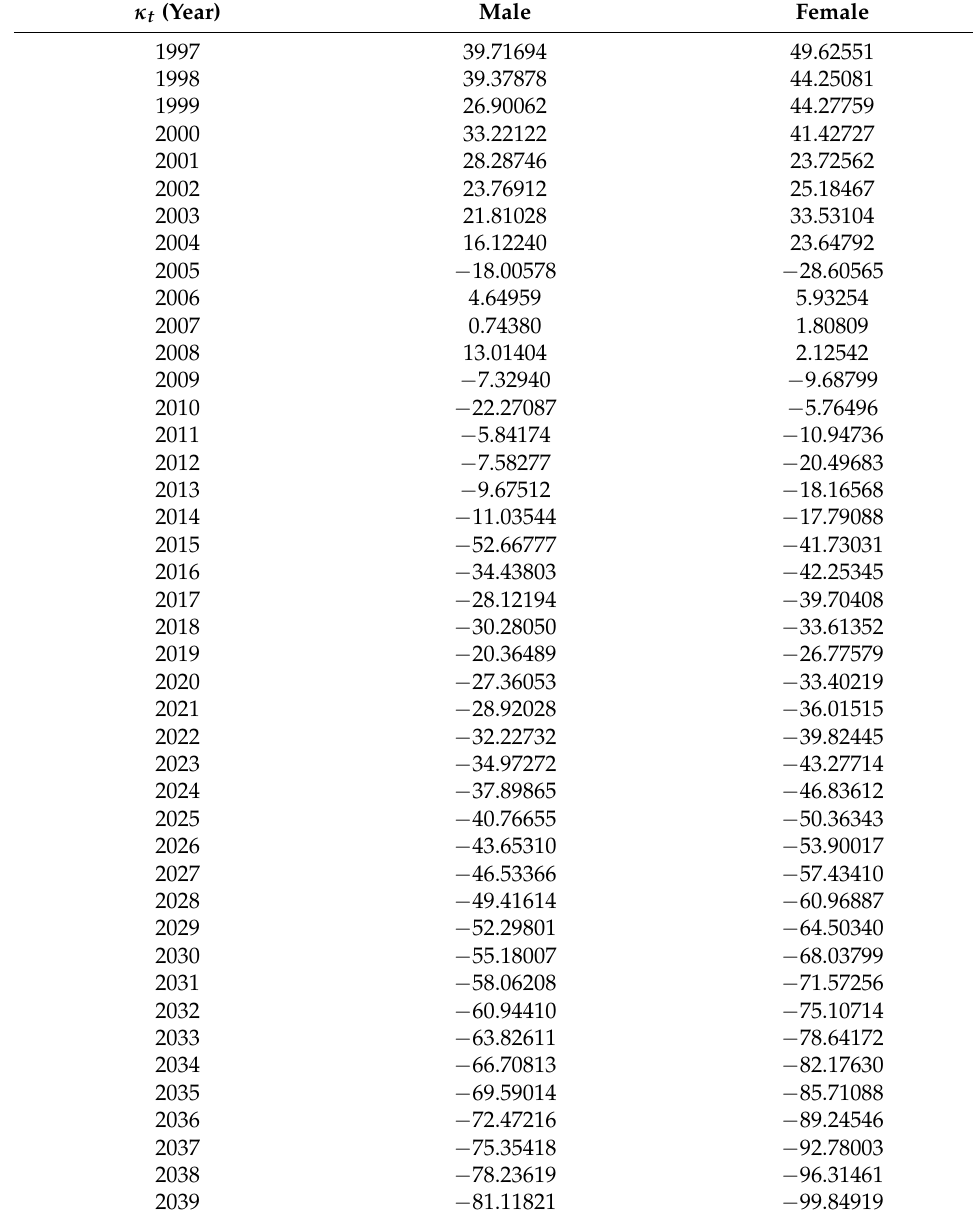
Table 1. This is the prediction of κ t